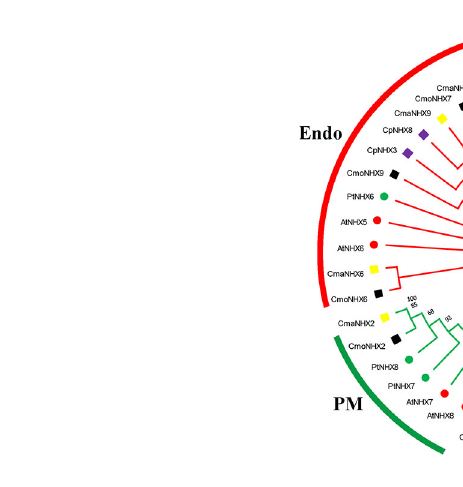
FIGURE 1 Phylogenetic trees of the NHX gene family in a number of species. Three subfamilies (Endo, PM and Vac) were displayed with evolutionary branches of different colors. The phylogenetic tree was constructed with MEGA 7.0 software using the Maximum Likelihood method with 1000 bootstrap replicates. Cmo, C. moschata ; Cma, C. maxima ; At, A. thaliana ; Pt, P. trichocarpa .